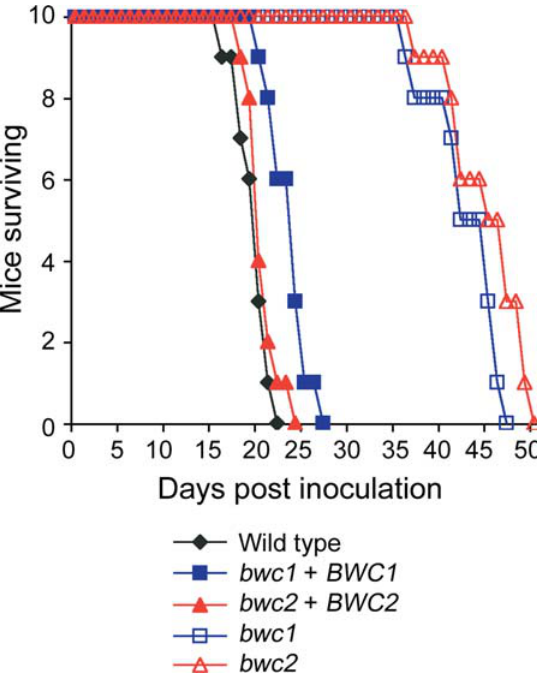
Figure 8. BWC1 and BWC2 Are Required for Full Virulence of C. neoformans in a Mammalian Host Ten mice each were infected intranasally with 1 3 10 5 cells of wild- type, bwc1 mutant, and bwc2 mutant, and reconstituted ( bwc1 þ BWC1 ; bwc2 þ BWC2 ) serotype A strains, and survival monitored daily. Mice infected with the wild-type and complementing strains progress to severe morbidity at the same rate, whereas mice infected with the bwc1 or bwc2 mutant strains survived twice as long. DOI: